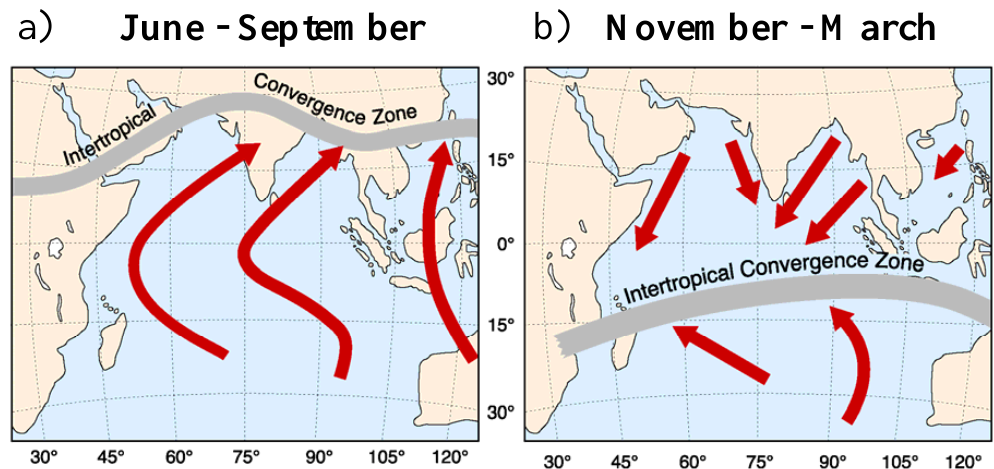
Fig. 5. Transport pathways for near-surface flow over the Indian Ocean during the (a) summer and (b) winter monsoon